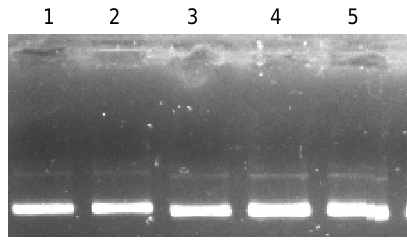
Figure 4. Effect of different concentration of 1-ethyl-3-methylimidazolium bromide (EMI) on the interaction with pUC19 DNA (7 m g/ml) in a Tris-HCl buffer (100 mM, pH 7.4) at 37 ºC for 0.5 h. Agarose gel electrophoresis diagram: lane 1, DNA control ; lanes 2-5, ligand: [EMI] = 5.6, 11.2, 22.4, 44.8, 89.6 mM.